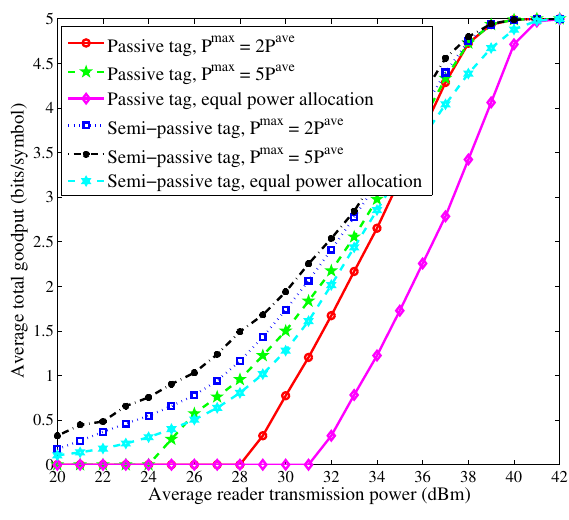
Figure 4. Average total goodput vs. average reader transmission power with N =